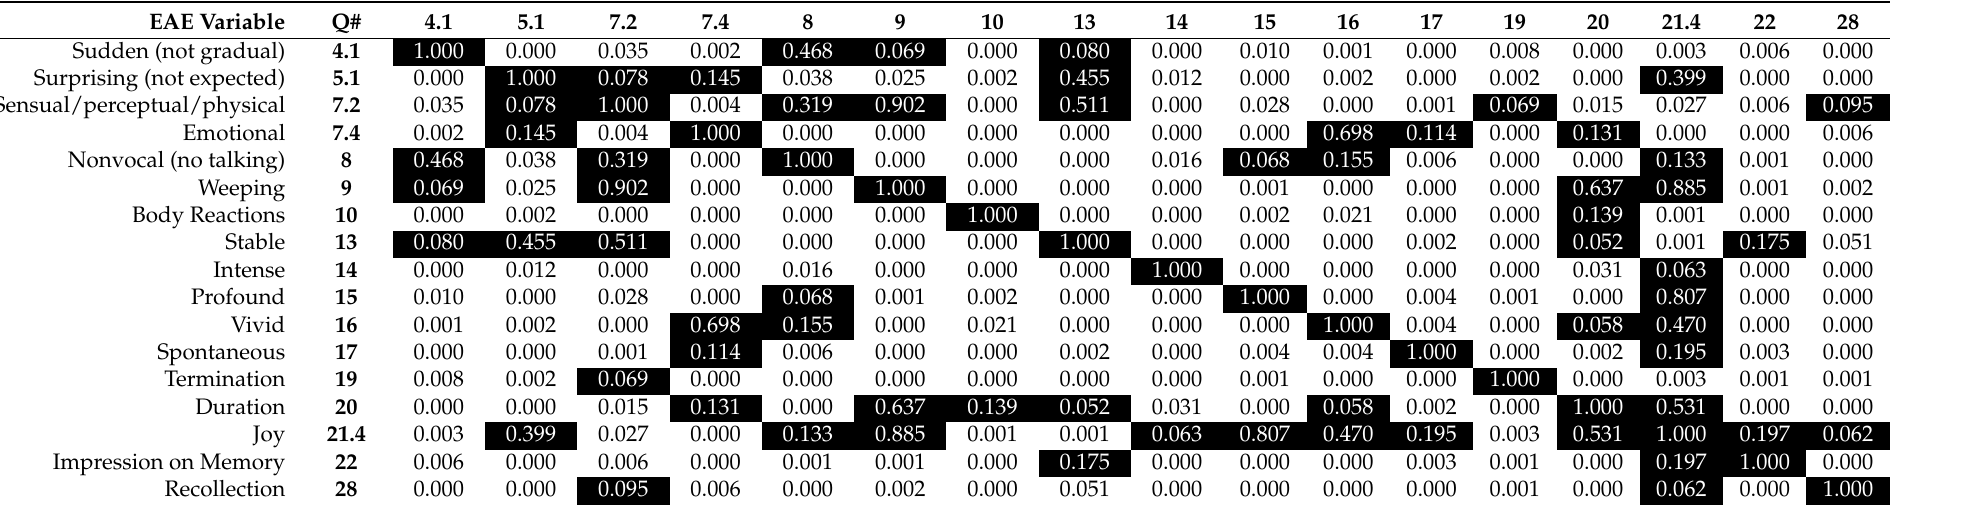
Table A1. Chi-Square test correlation matrix for “extraordinary architectural experience” (EAE) variables from Bermudez’s survey database and reorganized under Jones’ “theatre” category for ritual contexts. Any variable with a white background (not black) a considered a statistically significant correlation.